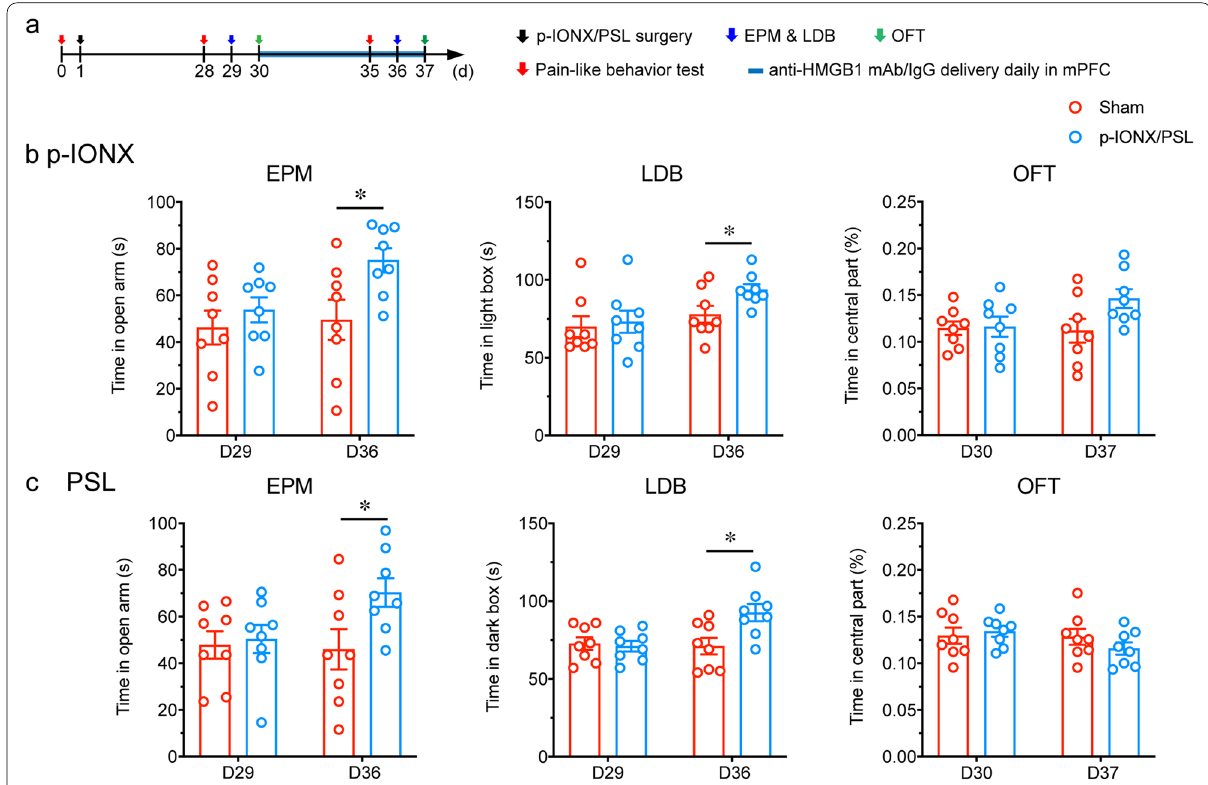
Fig. 5 HMGB1 upregulation in the mPFC maintained comorbid anxiety in neuropathic pain. a Schedule of procedures of mPFC drug delivery experiments in the late phase after p‑IONX. b, c Anxiety‑like behaviors measured by EPM, LDB and OFT on D29/30 and D36/37 after p‑IONX and PSL, respectively. * indicates P < 0.05, compared with the IgG‑treated groups, unpaired t test. n